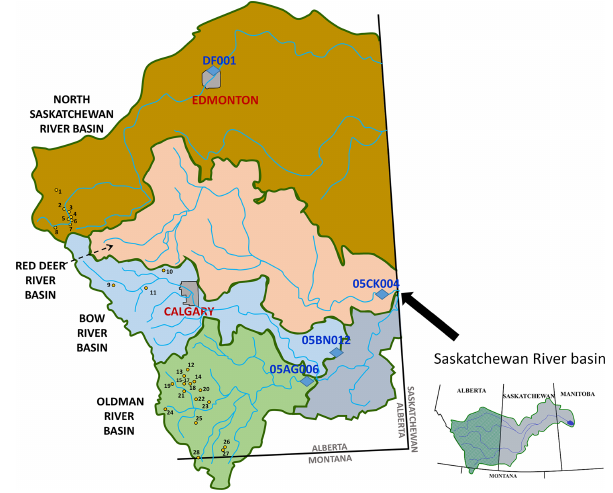
Figure 1. Map (adapted from Razavi et al., 2016) of the tributaries of the Saskatchewan River basin and the locations of the chronology sites (circles) and streamflow gauges